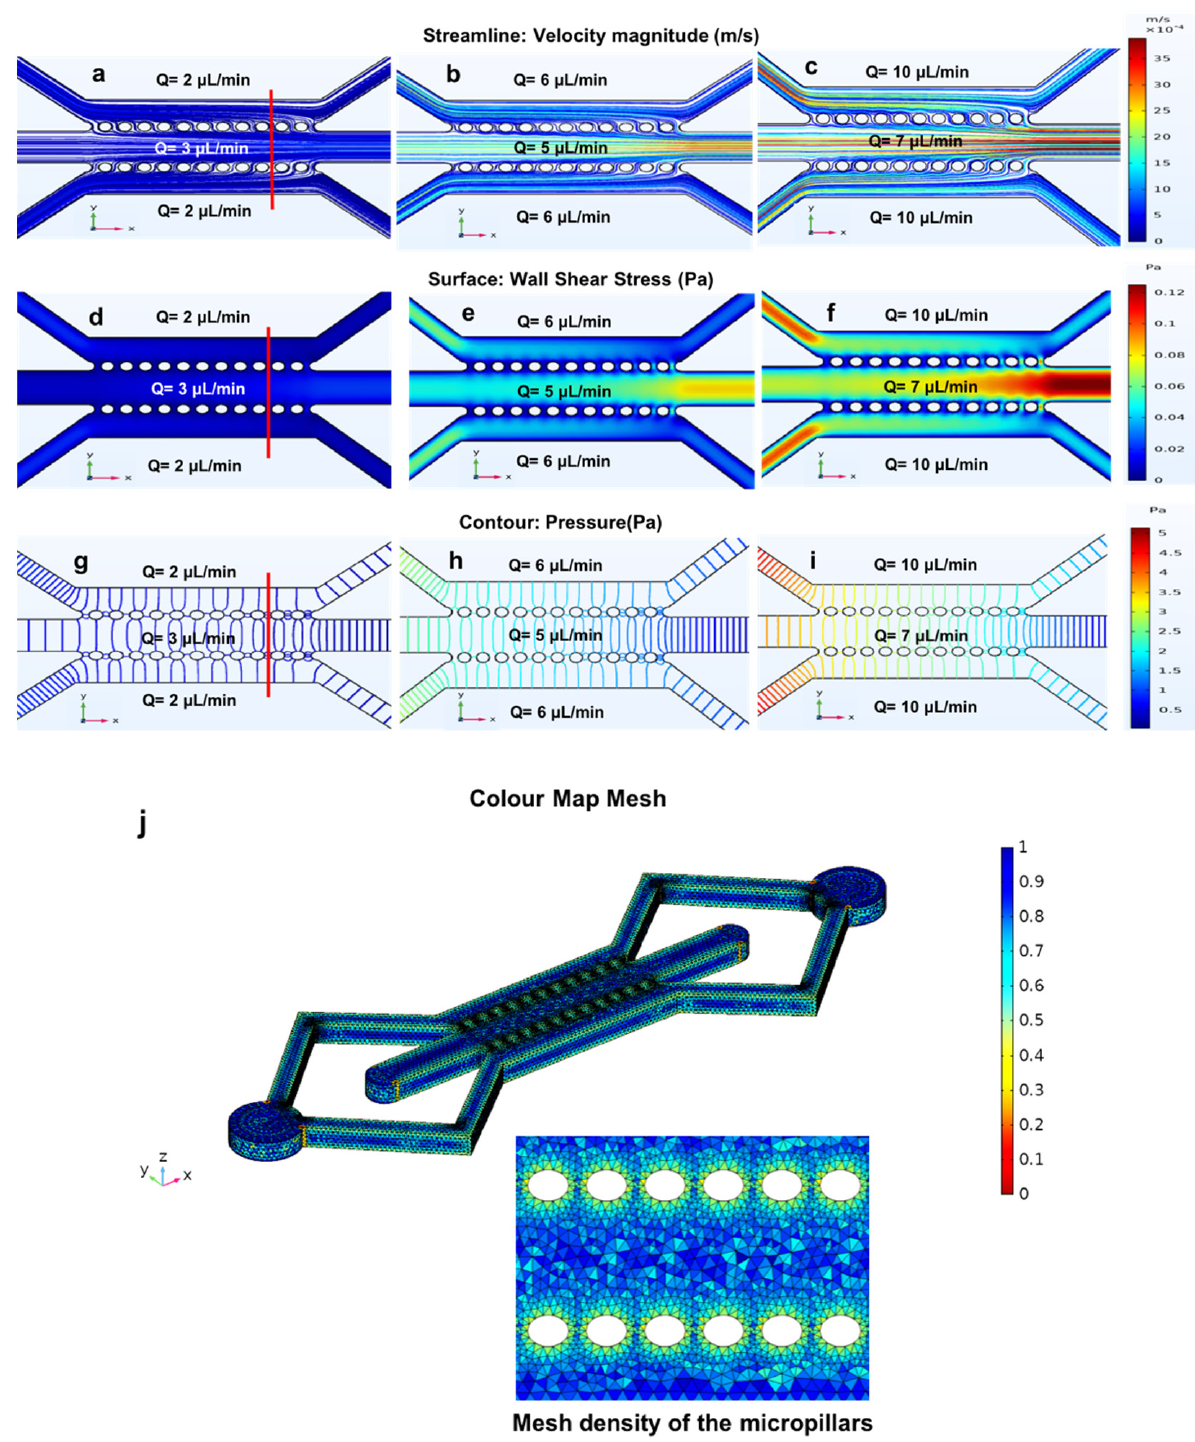
Figure 8. Simulated shear stress and velocity magnitude along the red line. ( a – c ) the fluid flow; ( d – f ) wall shear stress; ( g – i ) pressure simulations in a closed microchannel structure with a height of 200 µm using six different flow rates; ( a , d , g ) flow rates of 3 µL/min for the main microchannels and 2 µL/min for the side microchannels; ( b , e , h ) 5 µL/min for the main microchannels and 6 µL/min for the side microchannels; ( c , f , i ) 7 µL/min for the main microchannels and 10 µL/min for the side microchannels. ( j ) generated mesh density study for a closed microchannel structure.